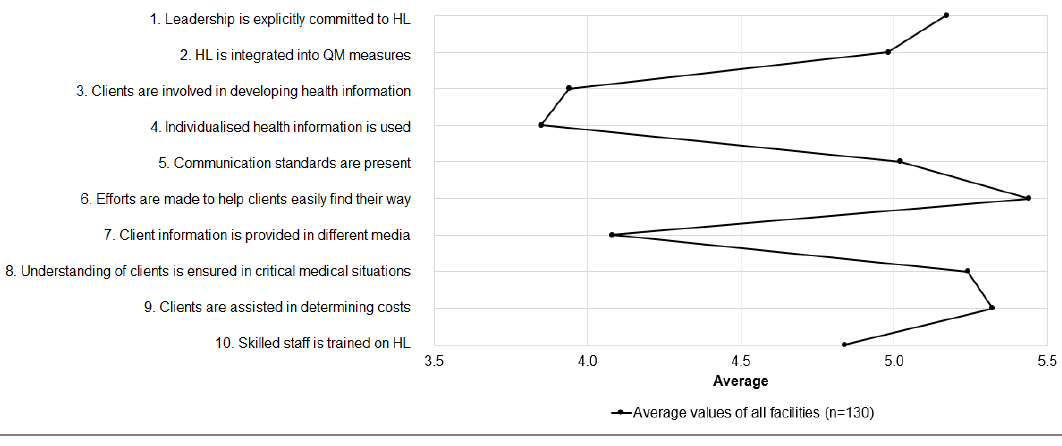
Figure 3. Figure 3. Mean values of the HLHO-10-items (N = 130). Note: HL = health literacy; QM = quality QM = quality management. management. Table 2. Descriptive statistics of the organizational health literacy (OHL) attributes ( N =